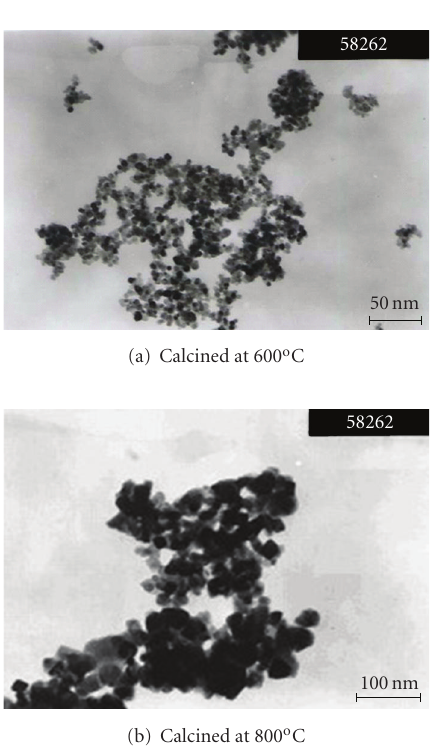
Figure 8: TEM photos of Nano Titania calcined at 600 and 800 ◦ C,